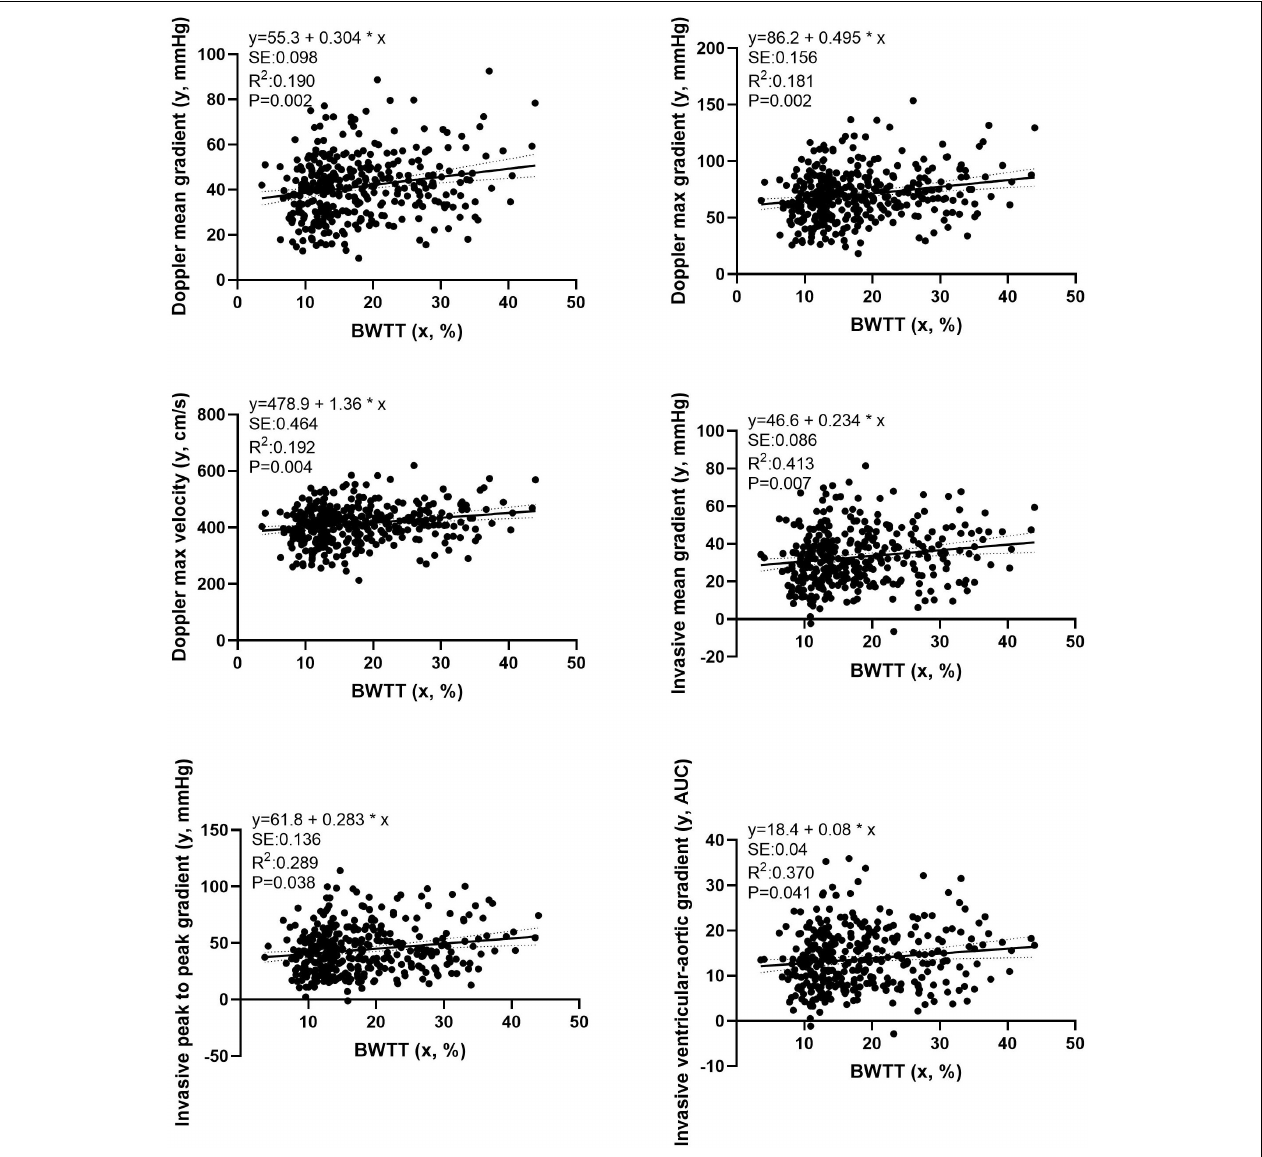
FIGURE 5 | Multiple linear regression analysis examining the independent effect of the BWTT on transvalvular pressure gradients obtained by either echocardiographic or invasive evaluation. Independent variables: Aortic systolic blood pressure; Aortic valve area (estimated by the Gorlin formula); Aortic characteristic impedance; Systemic vascular resistance; Total arterial compliance; gender and